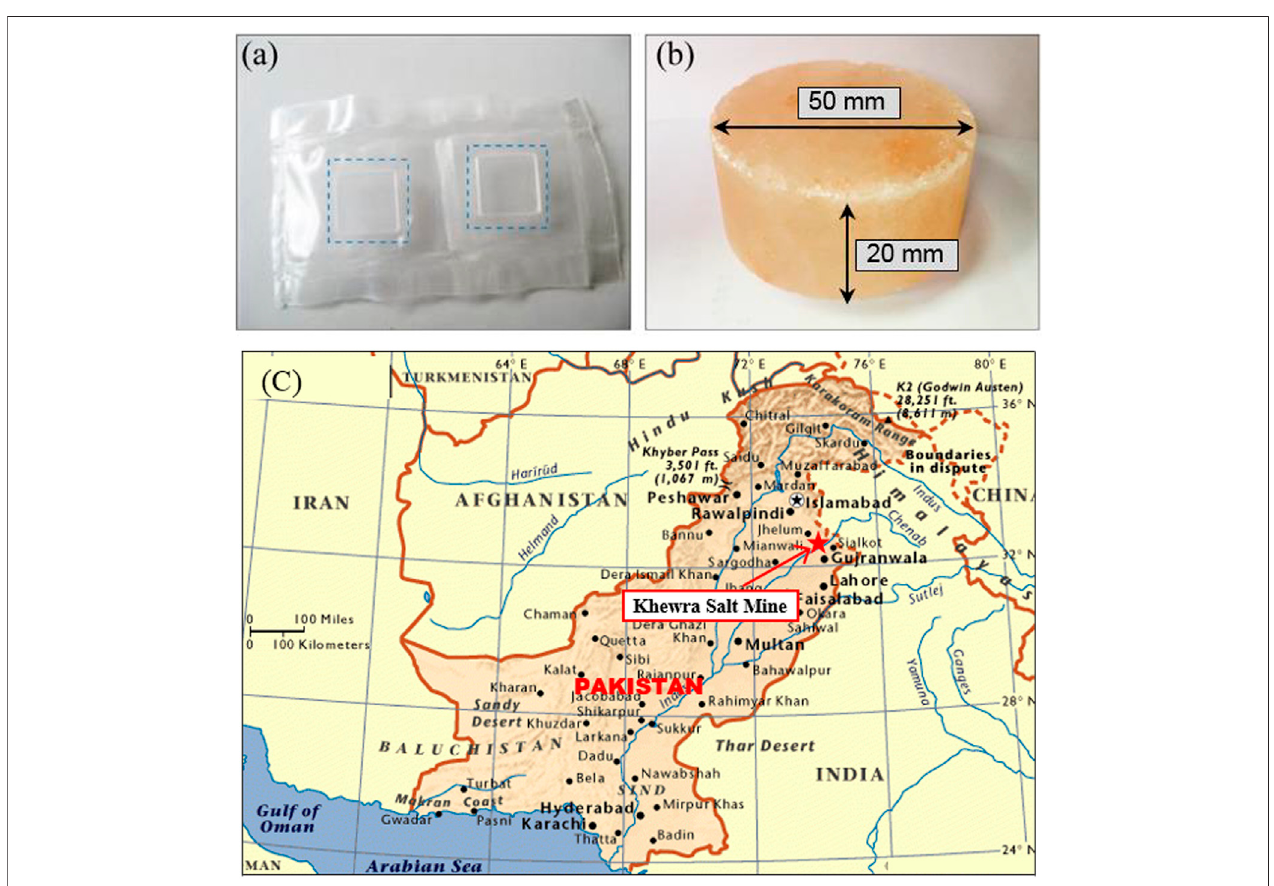
FIGURE 2 | The experimental specimens and origin of polycrystalline salt rock. (A) NaCl single crystal; (B) Polycrystalline salt rock from Khewra mines; (C) The location of Khewra salt mine, Pakistan.